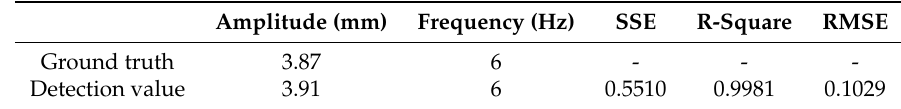
Table 1. Fitting evaluation parameters of reconstruction